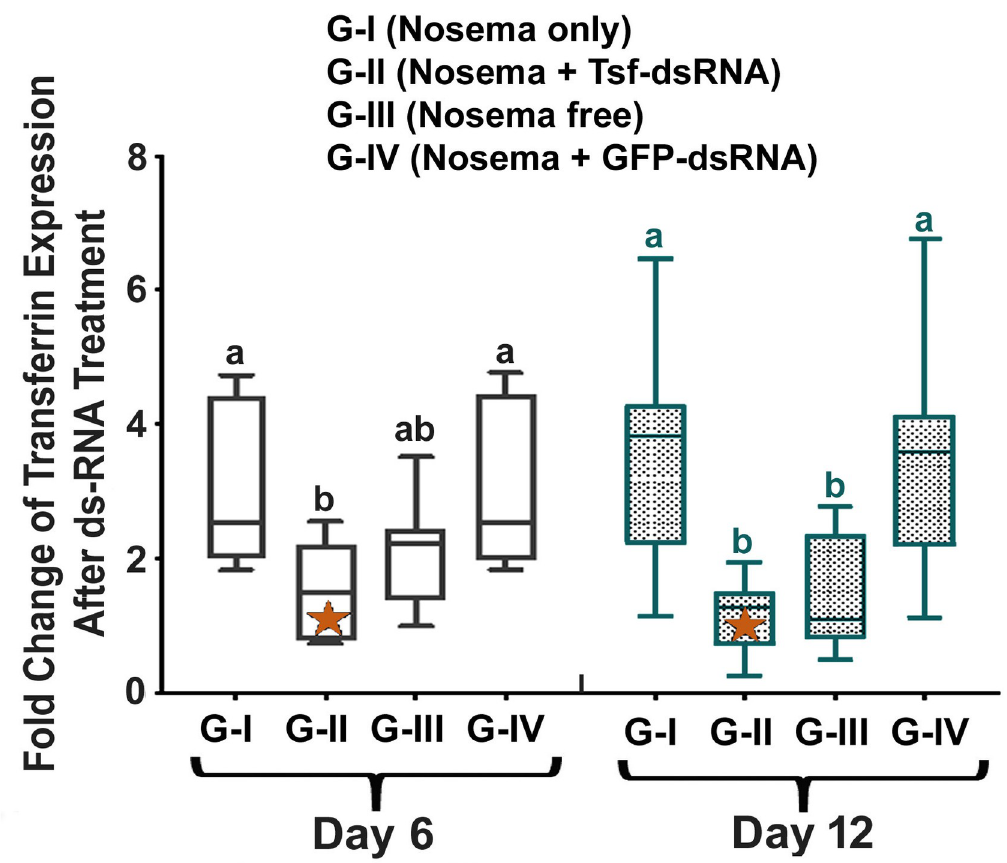
Fig 6. The relative expression of t ransferrin after treatment of AmTsf -dsRNA. The relative expression was expressed as an n-fold difference relative to the calibrator (marked by a star) by 2 – ΔΔ Ct method. A star denotes a calibrator and the different lower-case letters above bars indicate the statistically significant difference among different groups ( P � 0.05, ANOVA and Tukey´s tests).